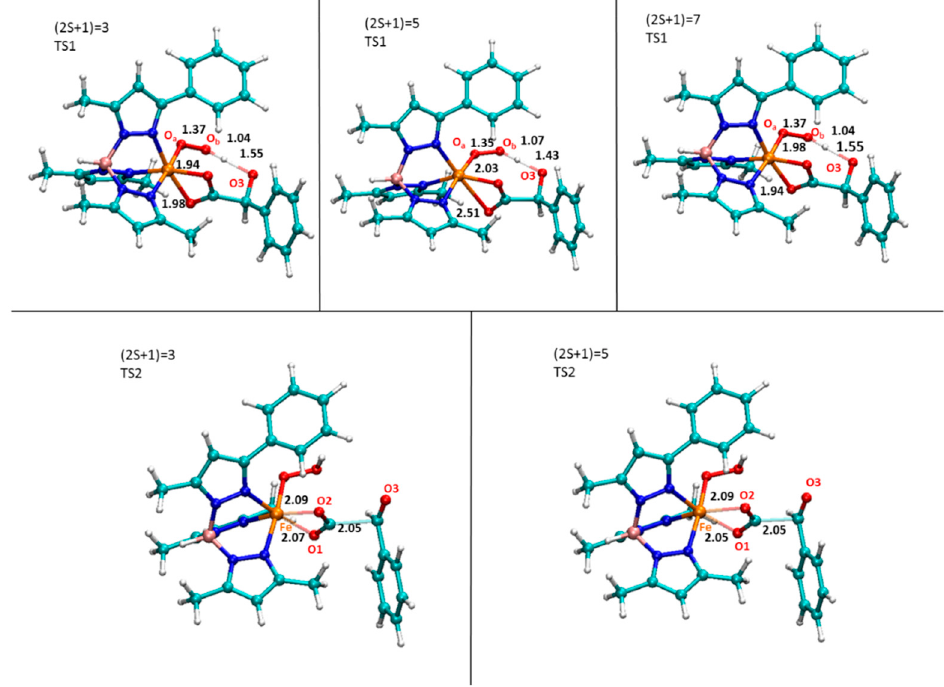
Figure 5. M06L optimized structures of TS1 and TS2 intercepted along the three explored PESs. Selected bonds are in Å.